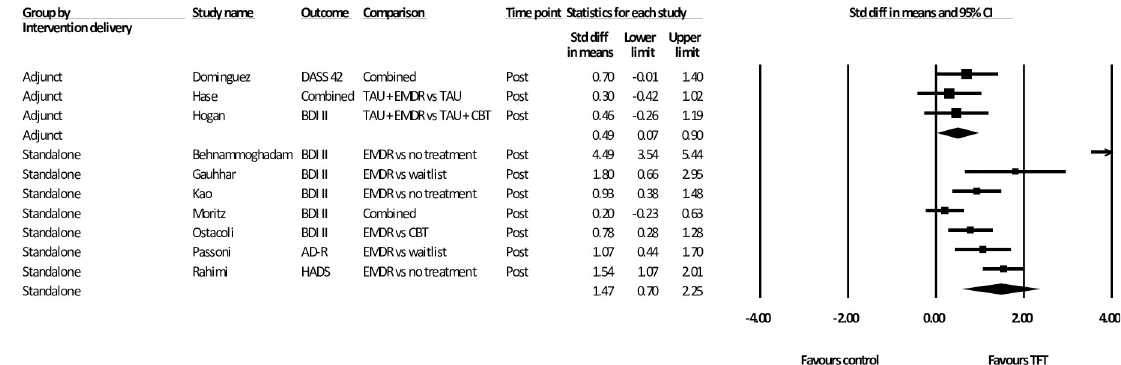
Fig 4. Subgroup analysis: Standardised effect sizes of trauma-focused treatments for depression delivered as an adjunct or standalone therapy, compared to control conditions.